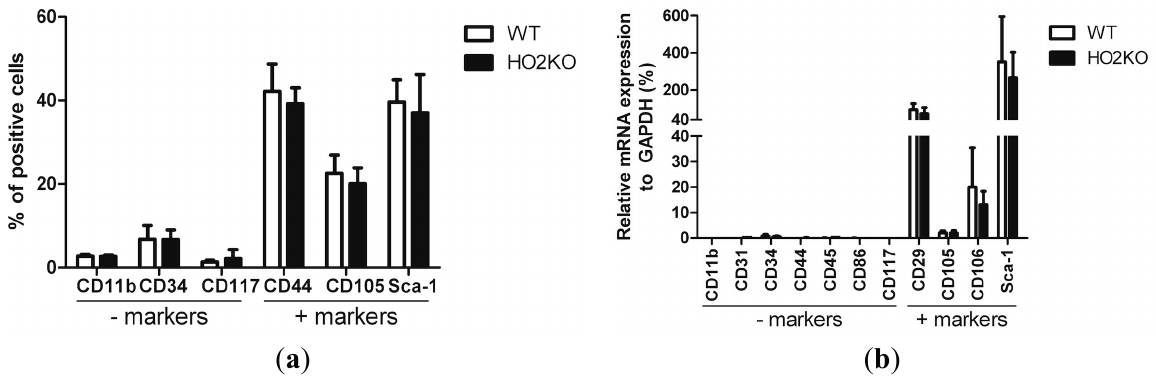
Figure 1. Phenotypic analysis of isolated WT (wild type) and HO-2 KO ASCs. ( a ) Percentage of positive cells for ASC exclusion markers (negative) and ASC cell surface markers (positive) of isolated WT and HO-2 KO ASCs, measured using flow cytometry; ( b ) mRNA levels of negative and positive ASC markers of isolated WT and HO-2 KO ASCs, analyzed by qPCR and presented as 2 −Δ C t . No significant differences were observed between in the expression of selected markers between WT and HO-2 KO ASCs using both flow cytometry and qPCR. Data represent mean ± SD of three independent